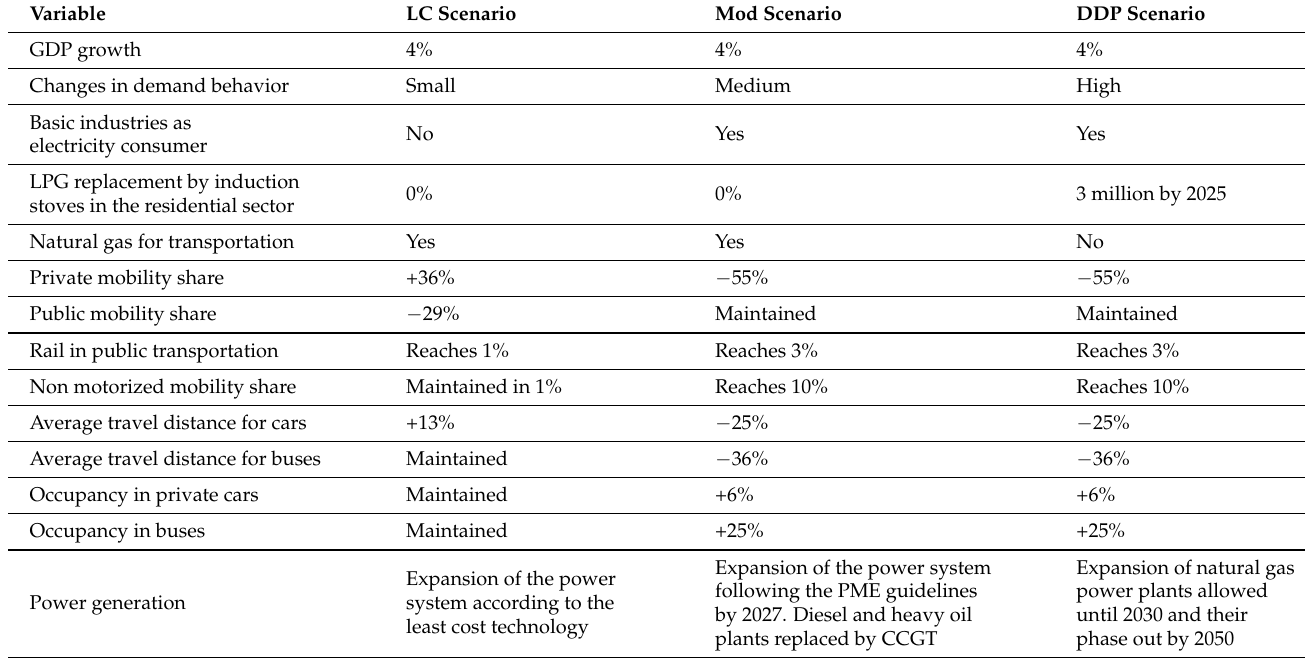
Table 1. Premises for the LC, Mod, and DDP